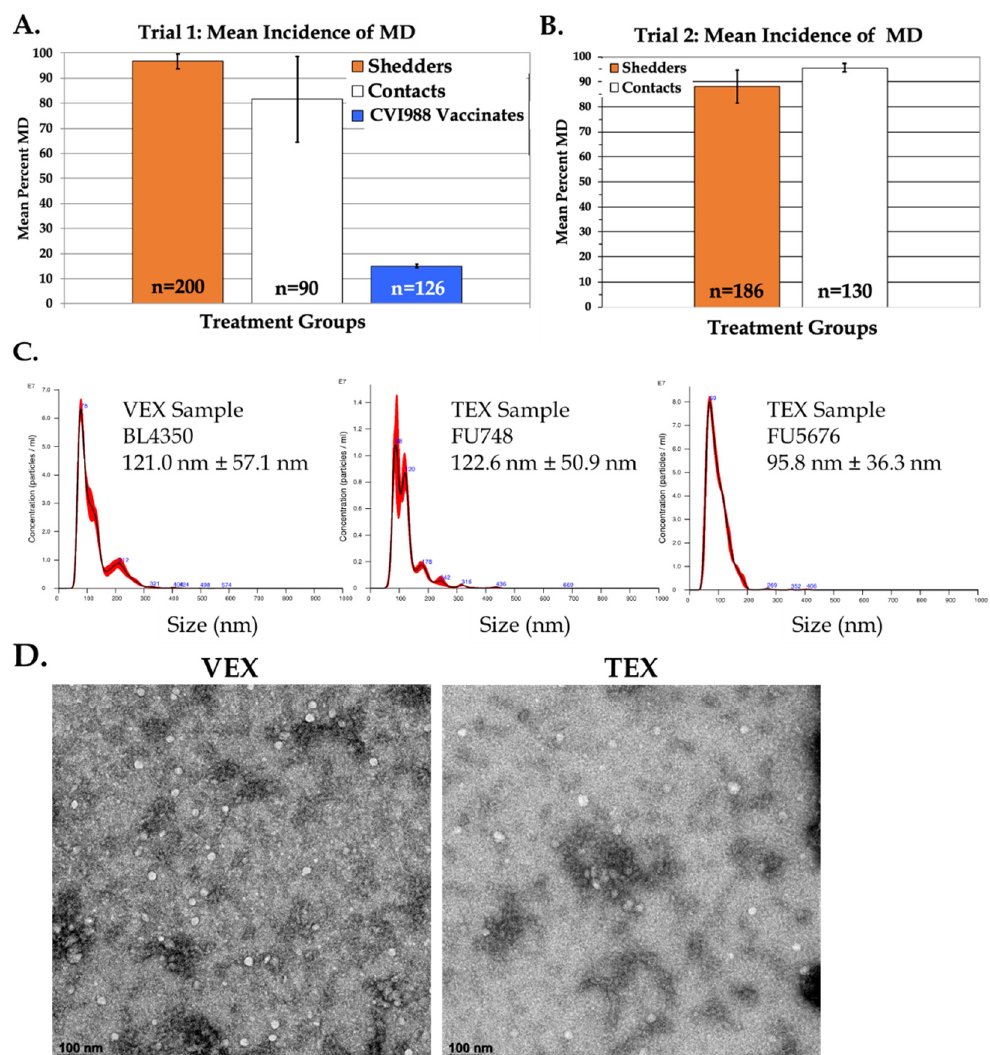
Figure 1. Exosome source, size, concentration, and ultrastructural characterization. Panels ( A , B ) show the Marek’s disease (MD) incidences of inoculated shedder (orange), contact-exposed, unvaccinated (white), and CVI988-vaccinated (blue) treatment groups. The numbers of birds for each treatment are given in the bars. Panel ( C ) shows the nanoparticle size distribution (± SD) and particle concentrations (log particles/ml) of representative VEX and TEX samples. Panel ( D ) shows representative transmission electron micrographs of Total Exosome Isolation (TEI) reagent-purified VEX and TEX. Vesicles were typically round and varied in diameter from approximately 30–120 nm. Scale bar = 100 nm.